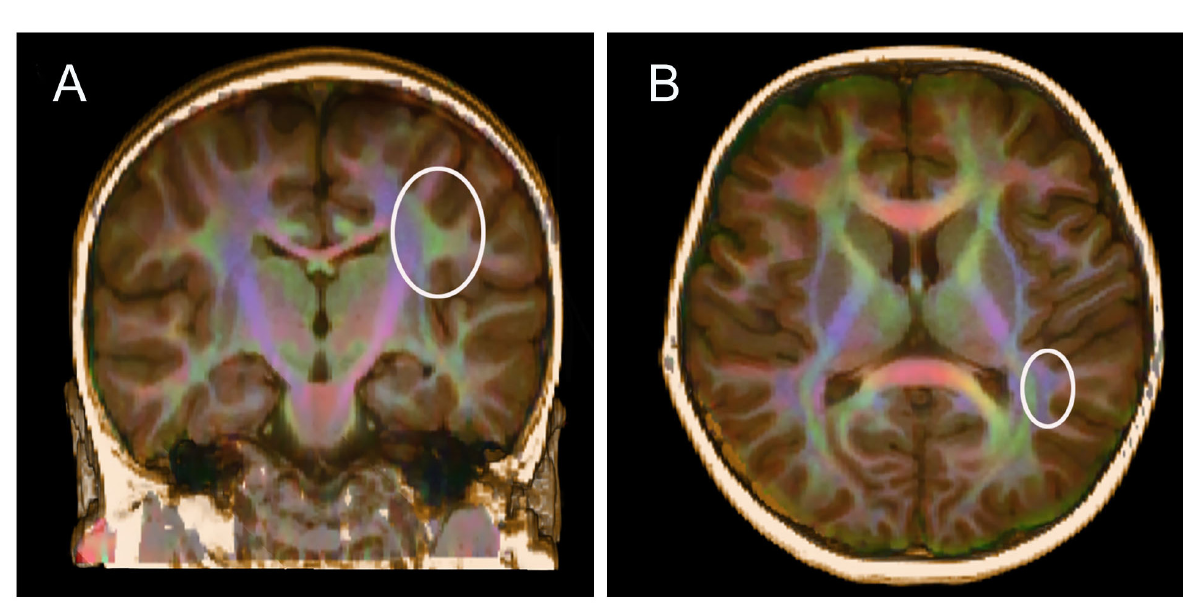
Figure 1. Tracking the AF: (A) The seed ROI is placed in the intense triangular-shaped green structure (circled) in the coronal plane; (B) A target ROI is placed in the blue structure lateral to the splenium of the corpus callosum in the transverse plane (circled)